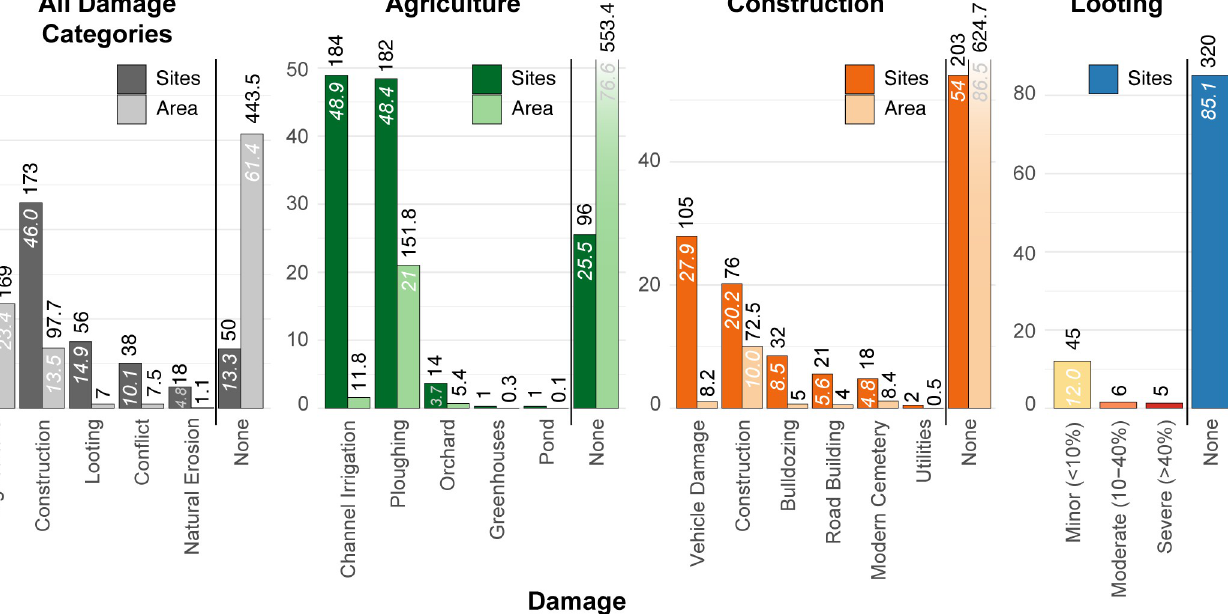
PLOS ONE | https://doi.org/10.1371/journal.pone.0269796 June 15,